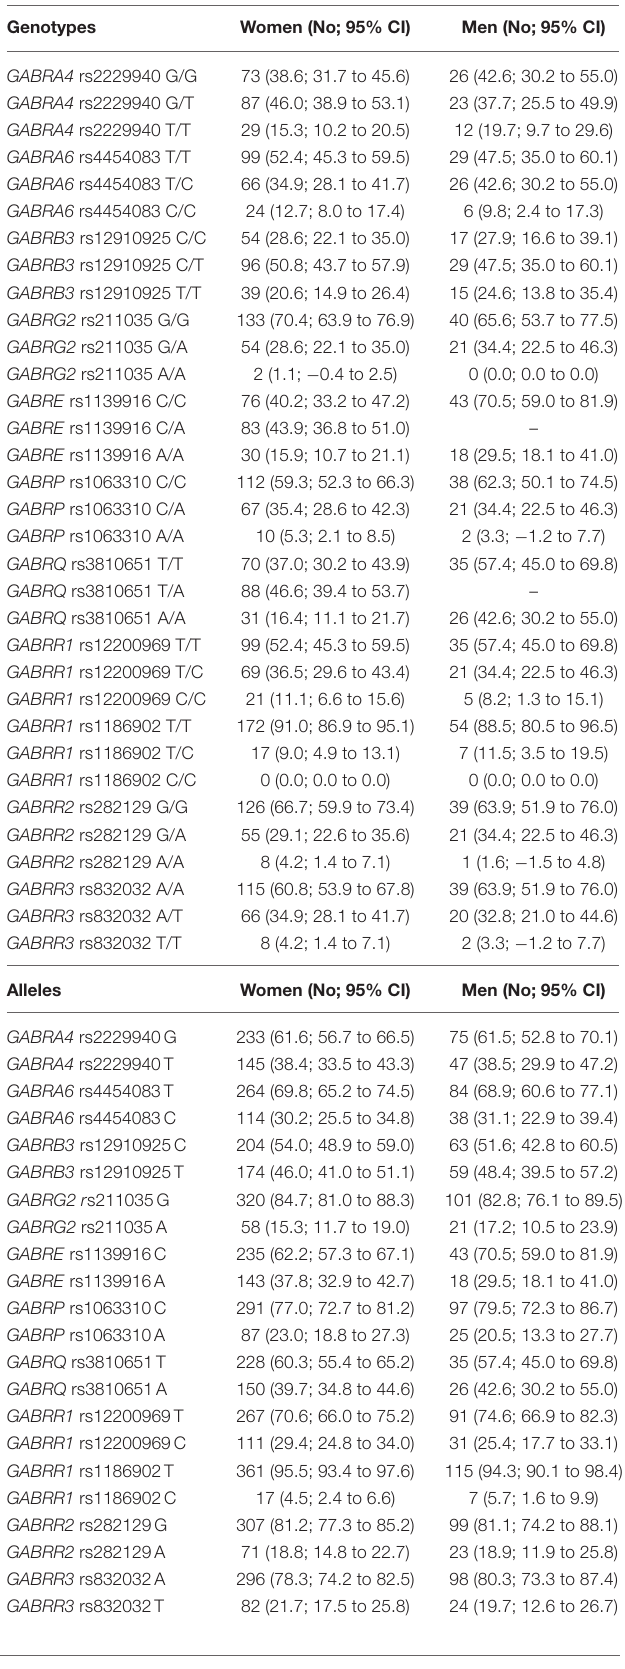
TABLE 2 | GABR genotypes and allele frequencies distributed by sex.